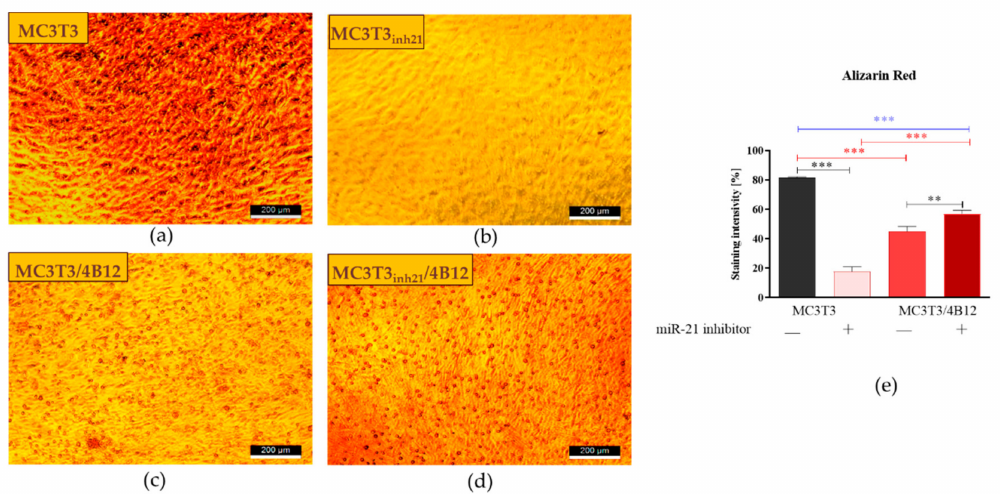
Figure 3. Representative images showing the results of Alizarin Red staining for calcium deposit detection. The mineralized extracellular matrix is stained with the dye. The images show an e ff ect of miR-21 inhibition on mineralization of extracellular matrix formed by pre-osteoblast. The analysis included the determination of osteoclast precursors’ activity (co-culturing with 4B12) on MC3T3 osteogenic di ff erentiation. Osteogenic di ff erentiation of MC3T3 was manifested by red calcium deposits ( a ). The decreased mineralization was observed in cultures of MC3T3 with blocked activity of miR-21 ( b ). The influence of 4B12 pre-osteoclast presence during osteogenic di ff erentiation was monitored both in co-culture with MC3T3 ( c ) and MC3T3 inh21 ( d ). Images were taken under 100-fold magnification (scale bar indicated). Staining intensity was determined using ImageJ software with Pixel Counter application, as indicated in Materials and Methods section ( e ). Significant di ff erences are marked using an asterisks (** p < 0.01 and *** p < 0.001), while non-significant di ff erences are described as ns . The comparisons between groups are marked with square